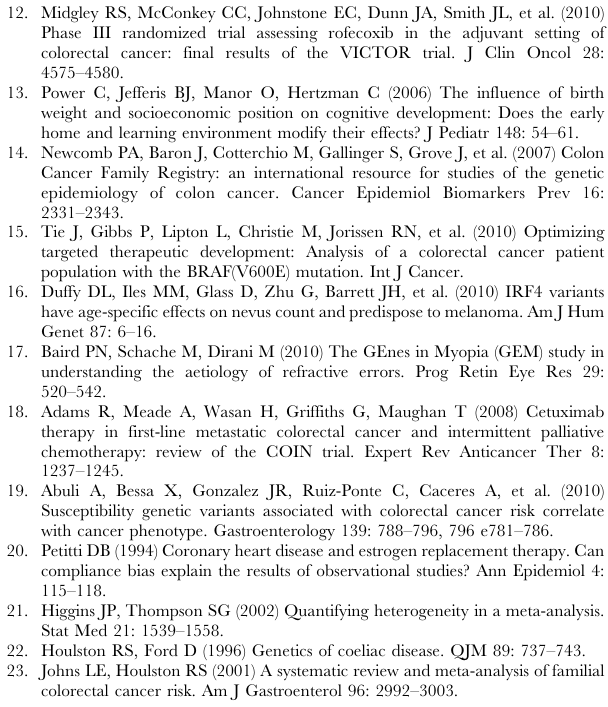
Table S3 Logistic regression model analysis of CRC risk and